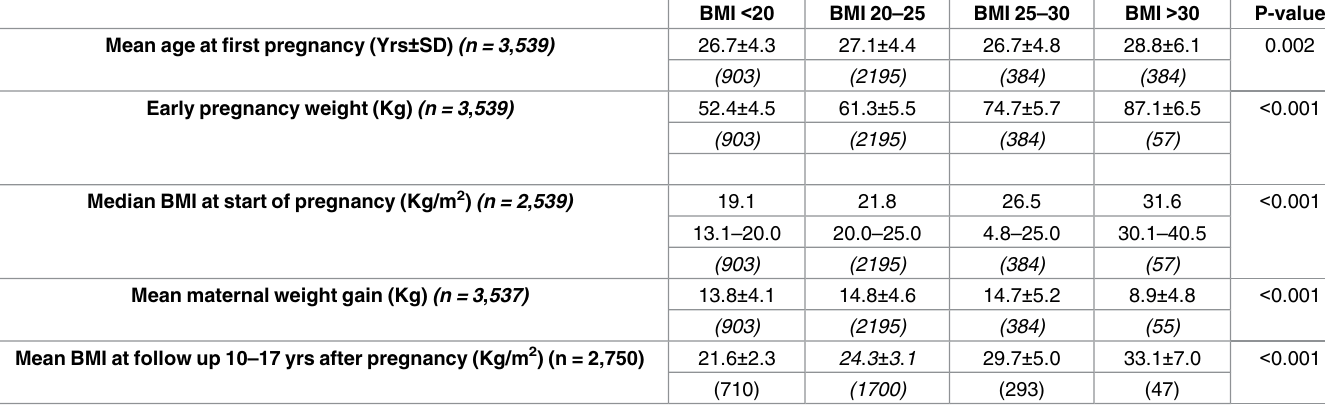
Table 1. Characteristics of women by BMI in early pregnancy.